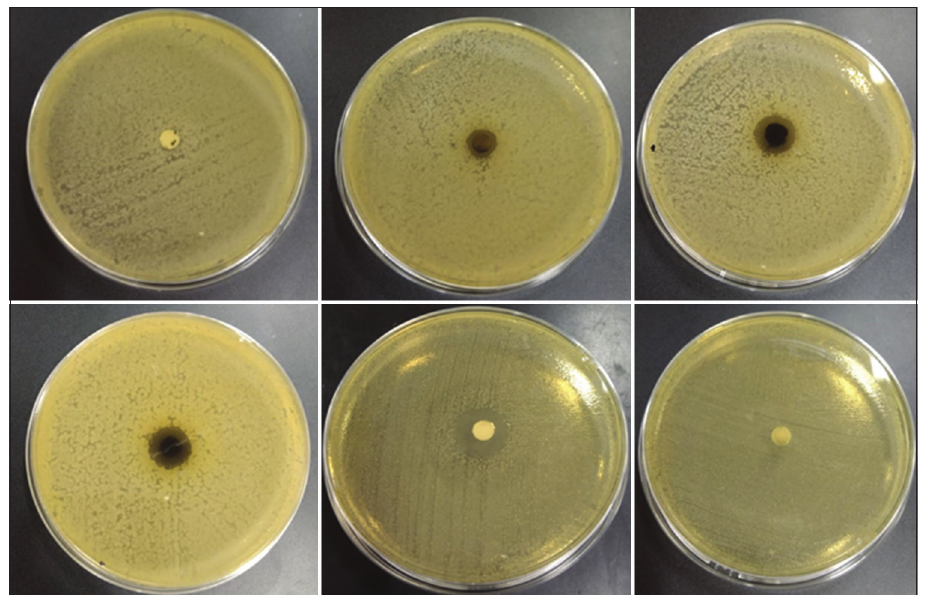
Figure-1: Diffusion results of Meniran extract. Description: The arrows point to the inhibition zone of each treatment.